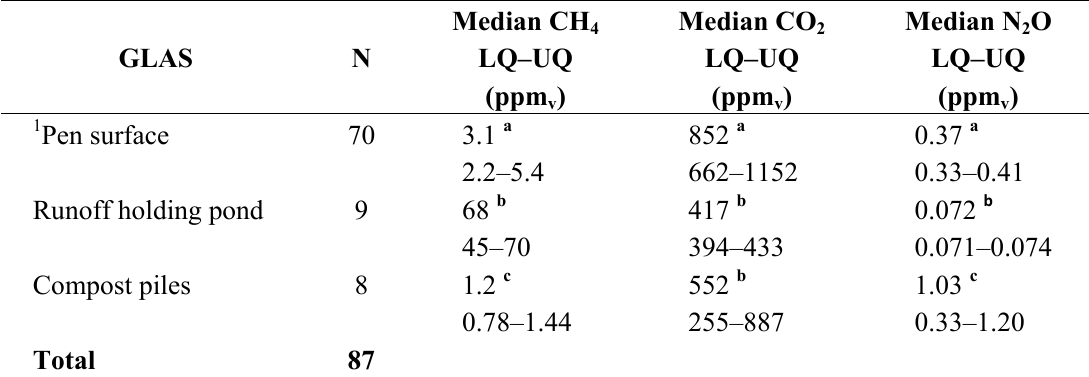
Table 4b. Volumetric concentration (median and quartiles) of GHGs measured from three major GLASs at a